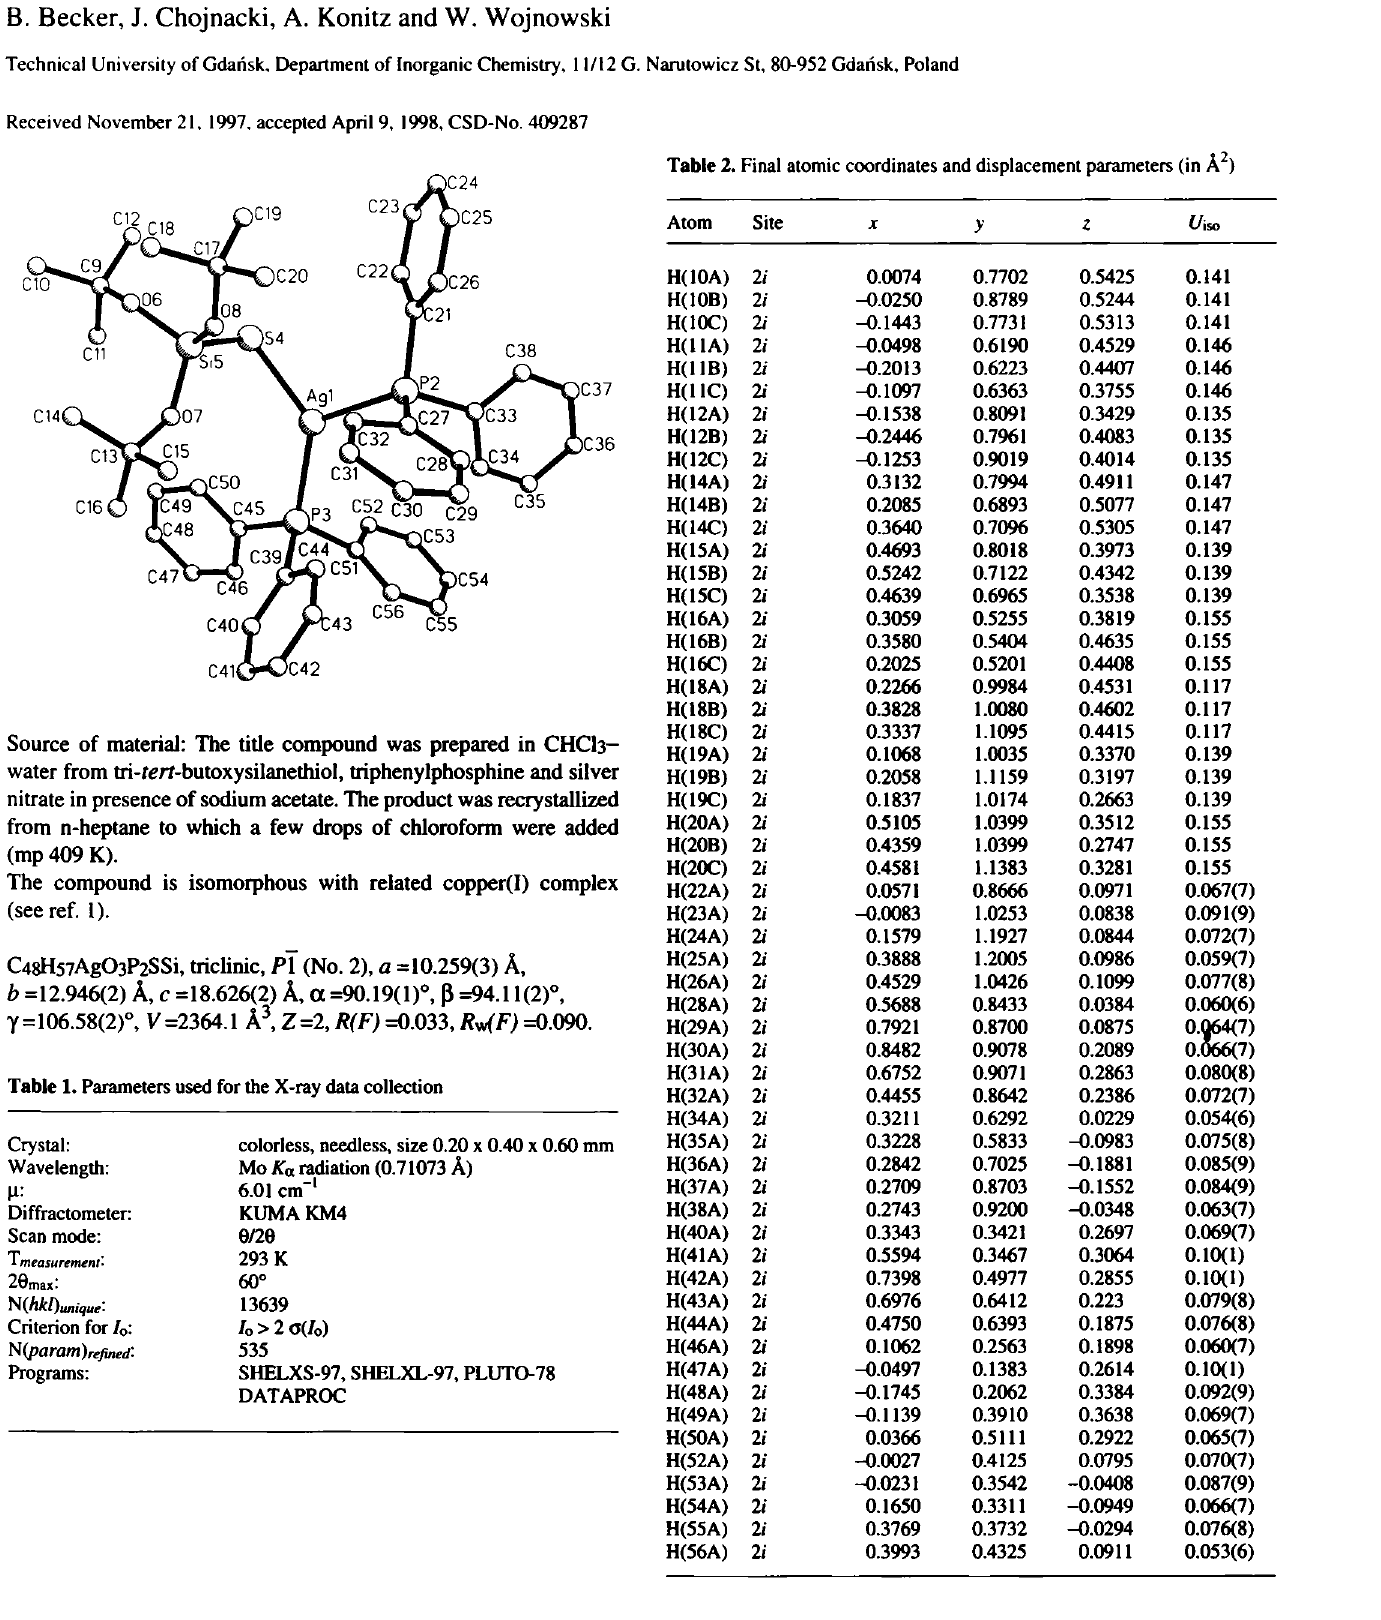
Table 2. Final atomic coordinates and displacement parameters (in